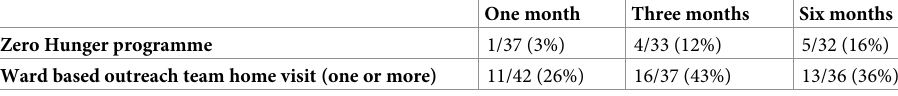
Table 5. Access to support services at one, three and six